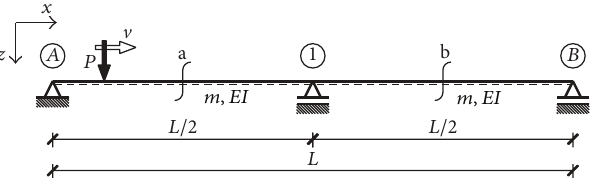
Figure 9: Two-span continuous uniform beam loaded with moving force.